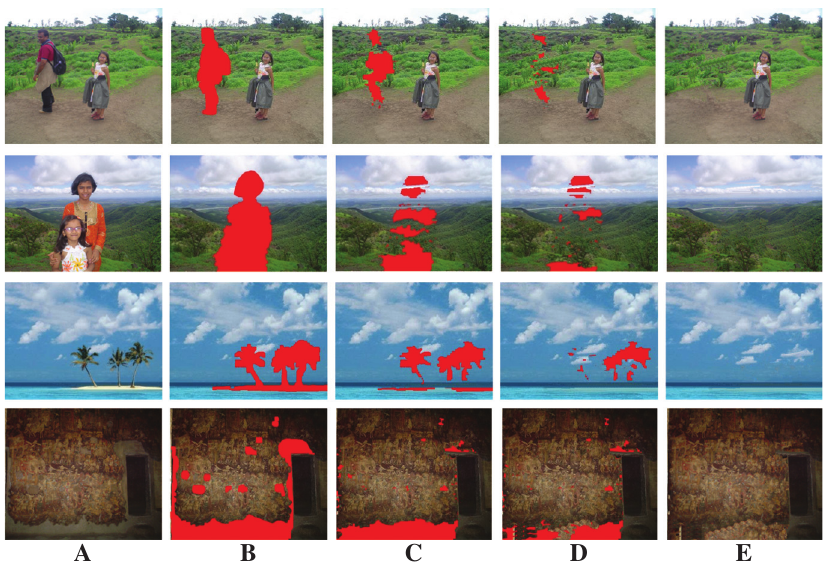
Figure 17. (A) The Original (B–D) are Intermediate Images. (E) The Inpainted Image by our Algorithm.